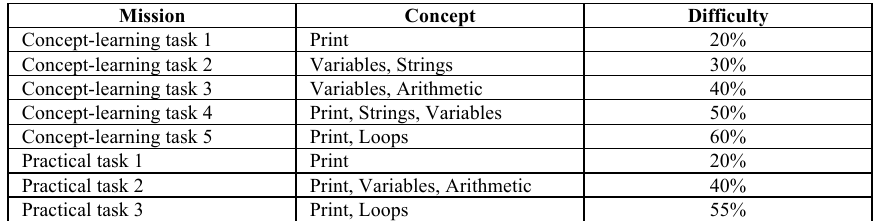
Table 2. Summarize the missions in the